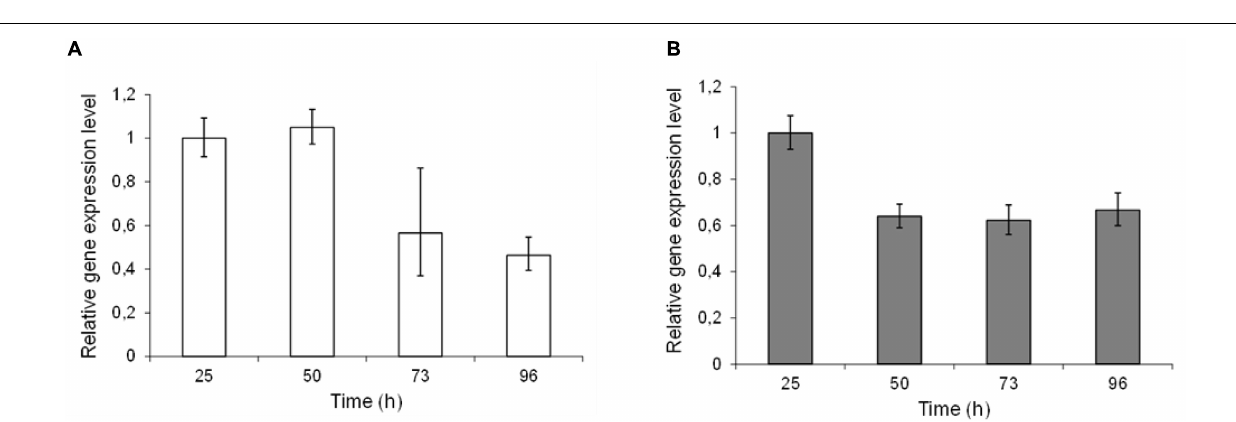
Frontiers in Plant Science |